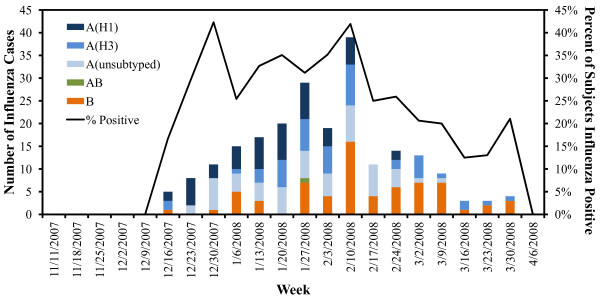
Distribution of laboratory-confirmed influenza cases and overall influenza rate, during the 2007–2008 influenza season. NOTE. Histogram depicts all laboratory-confirmed influenza cases in the study population, by type and subtype, throughout the duration of the study, along with the percentage of subjects who were positive for any influenza type by week.